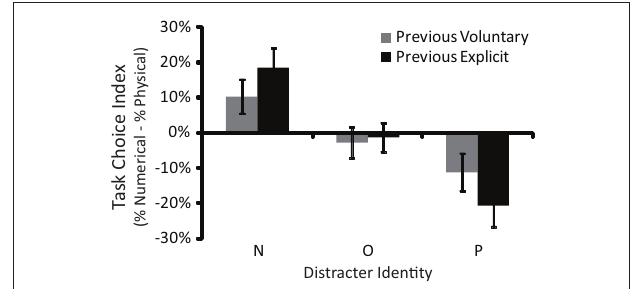
Figure 3 | Mean switch rate varied with an interaction between current distracter identity–previous task relationship and previous agency. When the current distracter identity (e.g., N) matched the previous task (e.g., the numerical size comparison task), switch rates were higher if the previous trial involved a voluntary task choice as compared to an explicit task choice. In contrast, when the current distracter identity (e.g., N) mismatched the previous task (e.g., the physical size comparison task), switch rates were higher if the previous trial involved an explicit task choice as compared to a voluntary task choice. Error bars represent 95% confidence